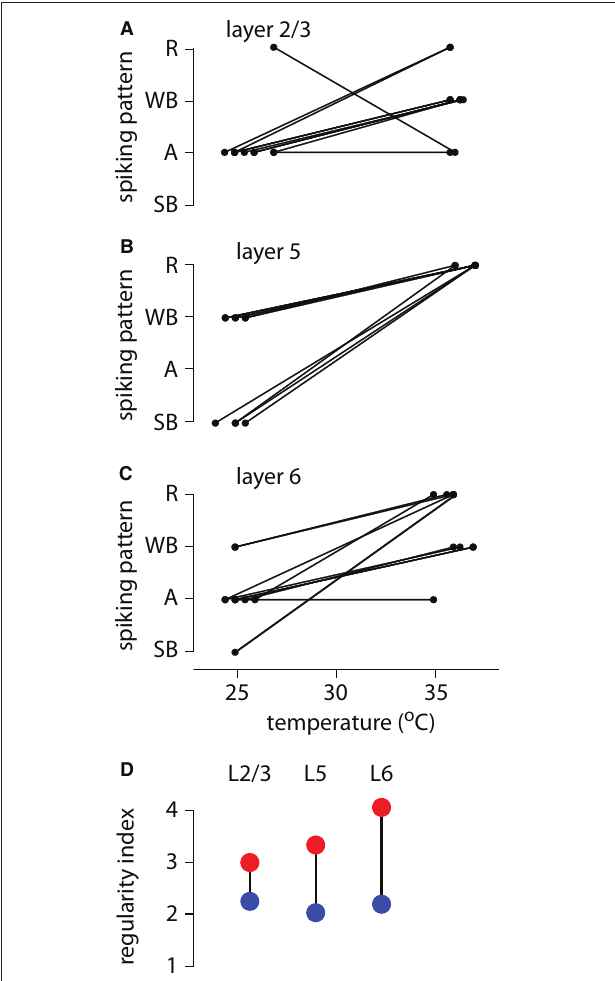
FIGURE 2 | Spiking patterns at low and physiological temperatures. (A) Summary of spiking patterns for 10 layer 2/3 pyramidal neurons at low and high temperatures. All neurons except for one display adapting spiking patterns (A) at low temperatures and regular spiking (R), weak bursting (WB) or adapting (A) at physiological temperatures. (B) Summary of spiking patterns at low and high temperatures for the same 10 layer 5 pyramidal neurons described previously (Hedrick and Waters, 2011), but were re-analyzed using our updated approach to classifying spiking patterns. (C) Summary of spiking patterns for 10 layer 6 pyramidal neurons at low and high temperatures. The majority of neurons were adapting at low temperatures and either weak bursting or regular spiking at physiological temperature. (D) Summary plot showing the decrease in regularity of spiking in layer 2/3, layer 5, and layer 6 pyramidal neurons with decreasing temperature. Blue dots and red dots represent average index of regularity at room temperature and physiological temperature,